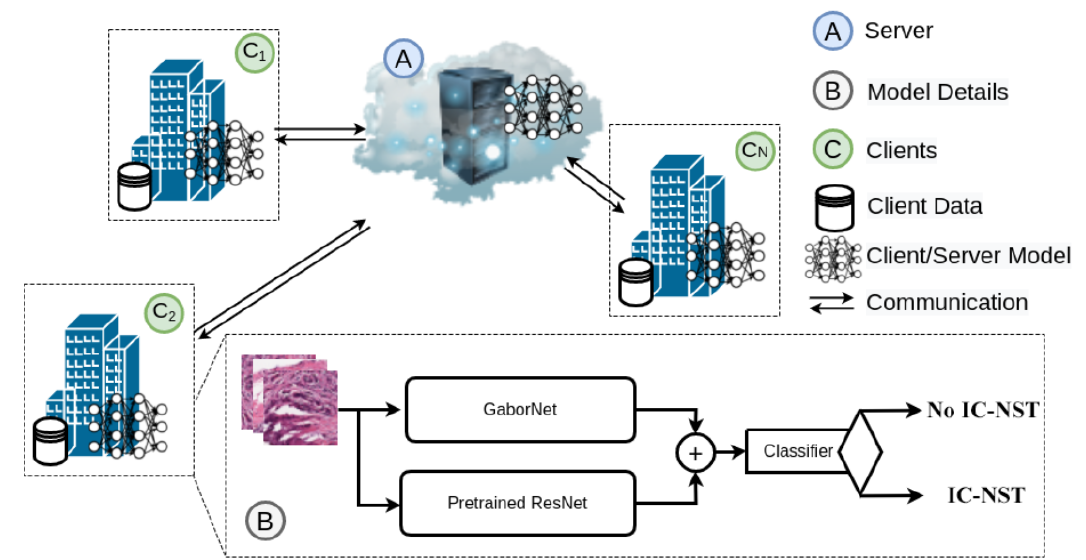
Figure 1. Architecture of the proposed approach with GaborNet and ResNet models on a feder- ated